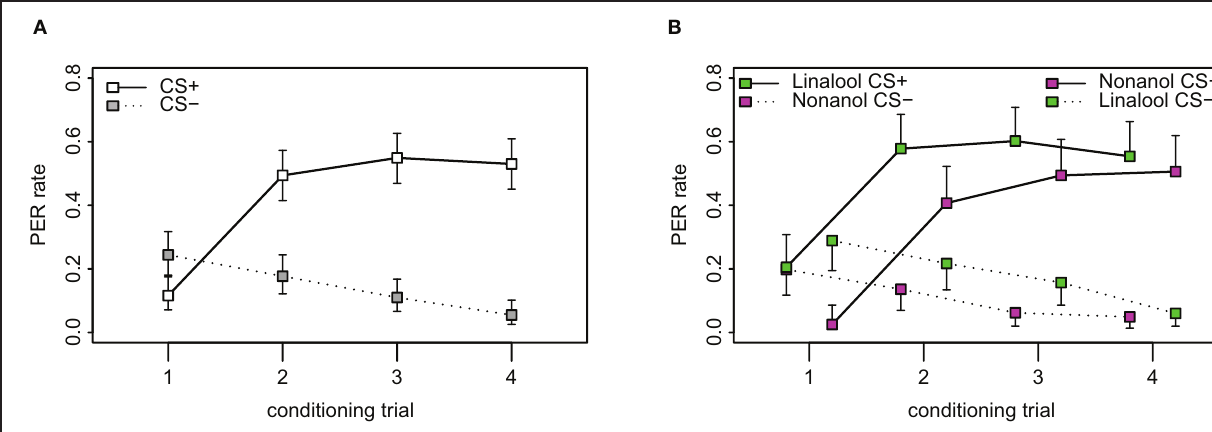
nonanol, respectively. Left shifted values indicate the responses from the group of bees conditioned with linalool as CS + and nonanol as CS − , while the right shifted values indicate the group that were conditioned with nonanol as CS + and linalool as CS − ( N = 82 for both groups). Linalool as CS + was more easily learned than nonanol as CS + ( p < 0 . 001, χ 2 = 39 . 8, df = 8, repeated measurement logistic regression with odor included as factor). Note also the higher spontaneous response for linalool as CS − for the first conditioning trial.